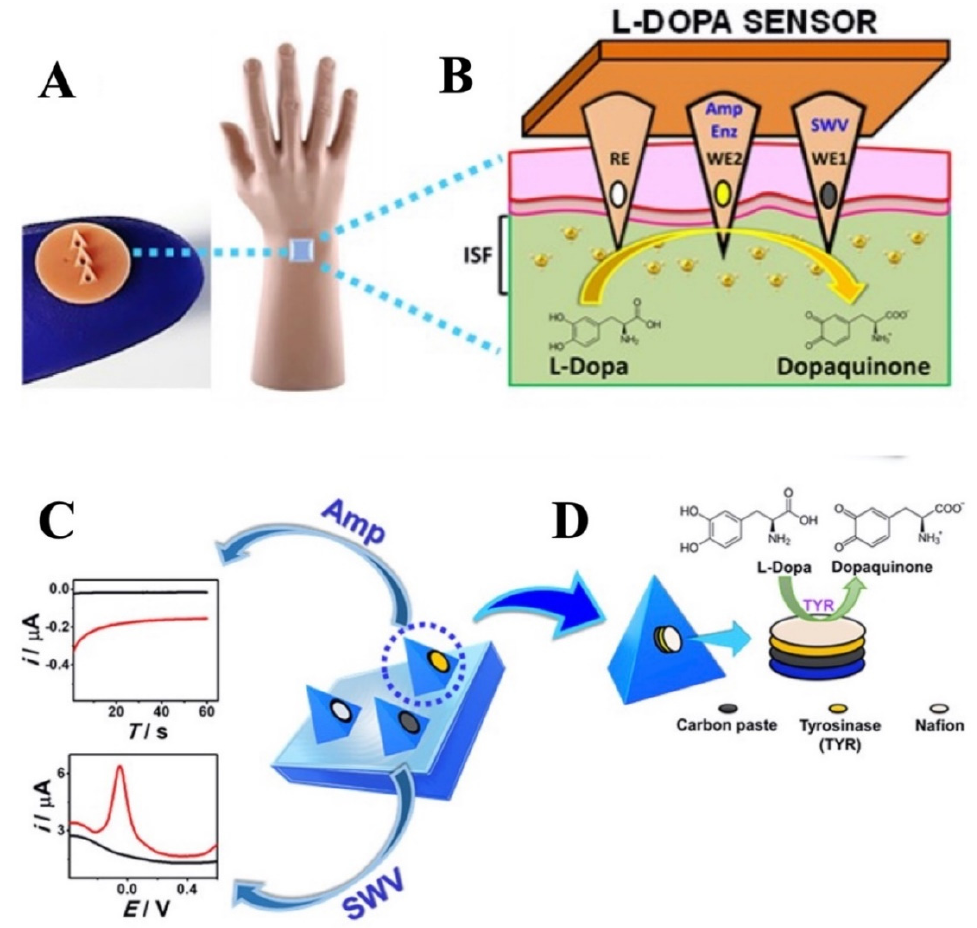
Figure 4. The schematic represents ( A ) the MN sensor and ( B ) the detection of L − Dopa in interstitial fluid. ( C ) The schematic illustration of the MN sensor platform depicts three electrodes for sensing Levodopa l through square-wave voltammetry and amperometry modalities. ( D ) MN sensor includes the corresponding reagent layers, i.e., the carbon paste, tyrosinase, and Nafion layer. Reprinted with permission from ref. [173]. Copyright 2019, ACS Publications.